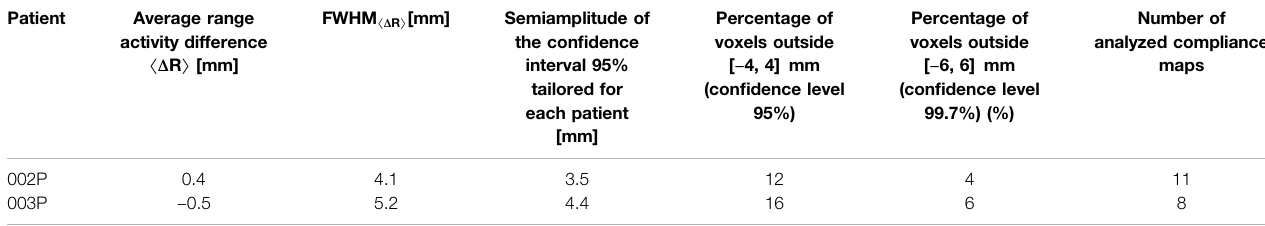
TABLE2| Resultsofpatients002Pand003Pandde fi nitionofthecomplianceintervalat95%con fi dencelevel,usedforthedesignoftheCLUTforthecompliancemap.The percentages of outlier voxels when considering a level of con fi dence of 95 ( ± 4 mm) or 99.7% ( ± 6 mm) and the total number of produced compliance maps, corresponding to the analyzed fractions, are also